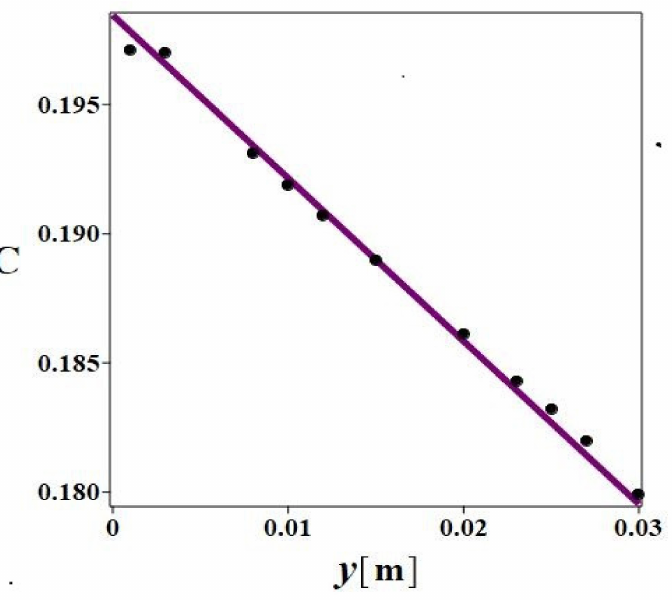
(cid:0) (cid:1) x = 2.5 · 10 − 4 m as a function of height y , for toluene–methanol